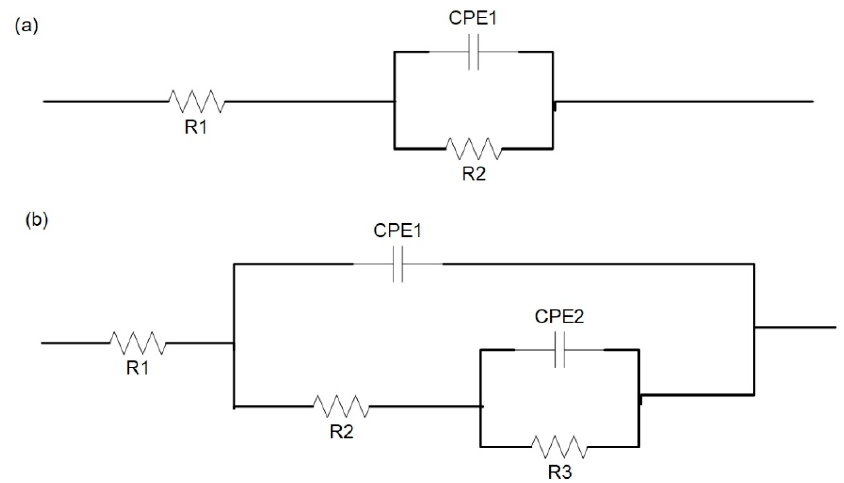
Table 2. The results of the EIS curves of the Zn-Mn-Mg alloys and fabricated by the MAO with different NaF concentra- Figure 7. The EIS data equivalent circuit of the Zn-Mn-Mg alloys and fabricated by the MAO with tions from 0.5 g/L to 2.5 g/L in Hank’s solution at 37 °C. different NaF concentrations from 0.5 g/L to 2.5 g/L in Hank’s solution at 37 °C: ( a ) Zn-Mn-Mg al- loys; ( b ) MAO NaF (g/L)